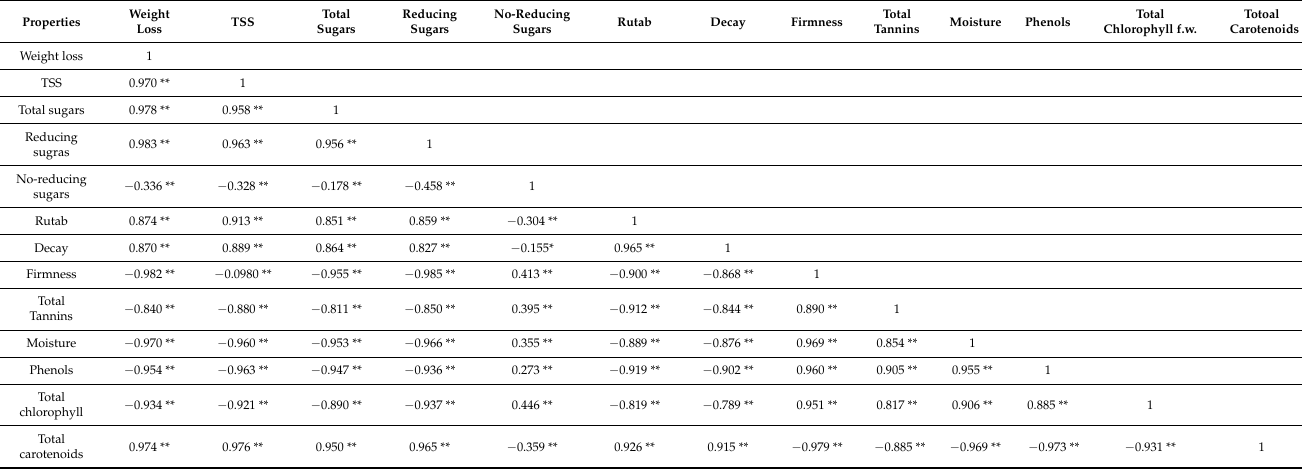
Table 2. Correlation matrix among the different properties of the stored Barhi